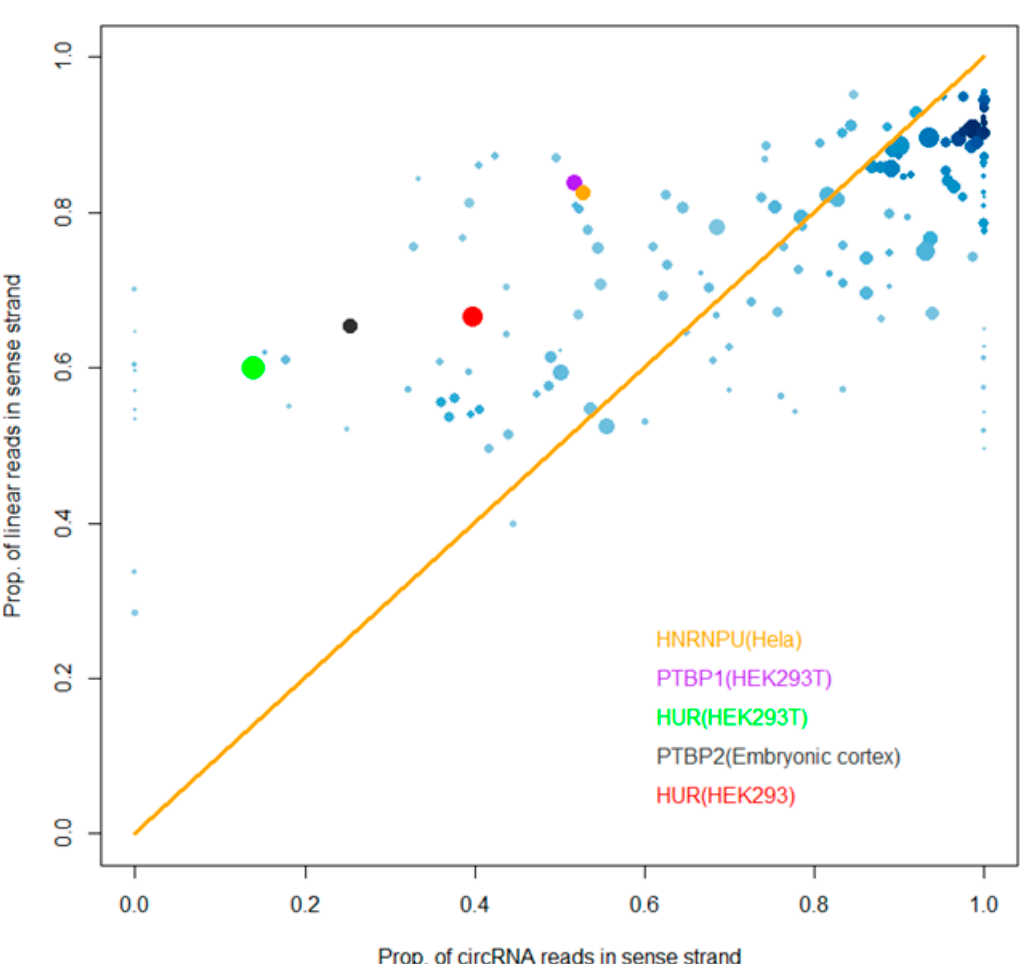
Figure 4. Proportion of circRNA reads in the same strand of the parental genes (x) vs. proportion of CLIP-Seq reads mapped to linear transcripts in sense strand (y). Dot size represents number of circRNA sequences in a study. The CLIP-Seq reads whose circRNA sequences are more than 500 and whose absolute (x-y) difference is more than 20% are labeled at the bottom right corner.